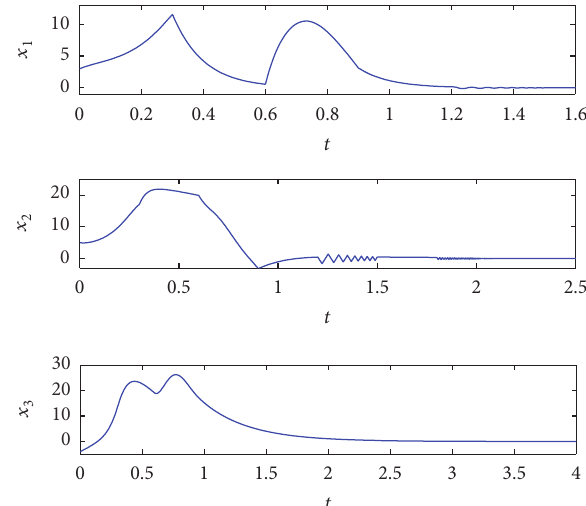
Figure 2: Orbits of controlled system (45) with 𝑥 1 (0) = 3 , 𝑥 2 (0) = 5 , and 𝑥 3 (0) = −4